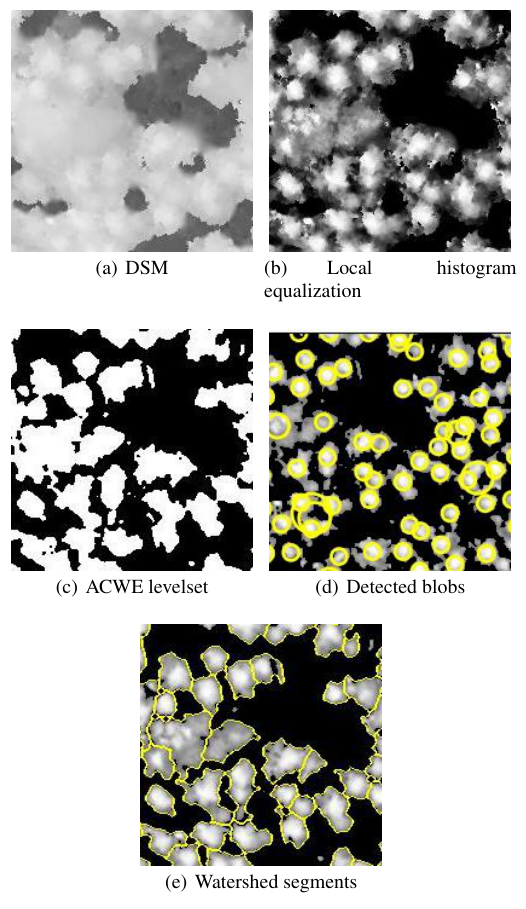
Figure 6. Illustration of the main processing steps of